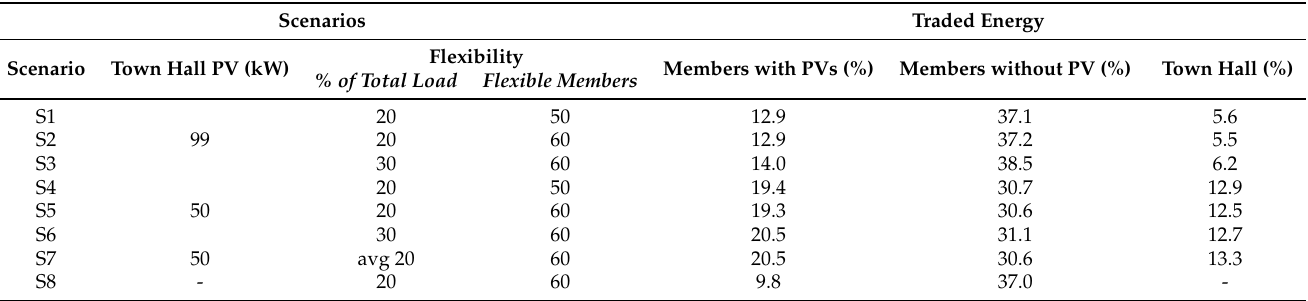
Table 4. Community traded energy.